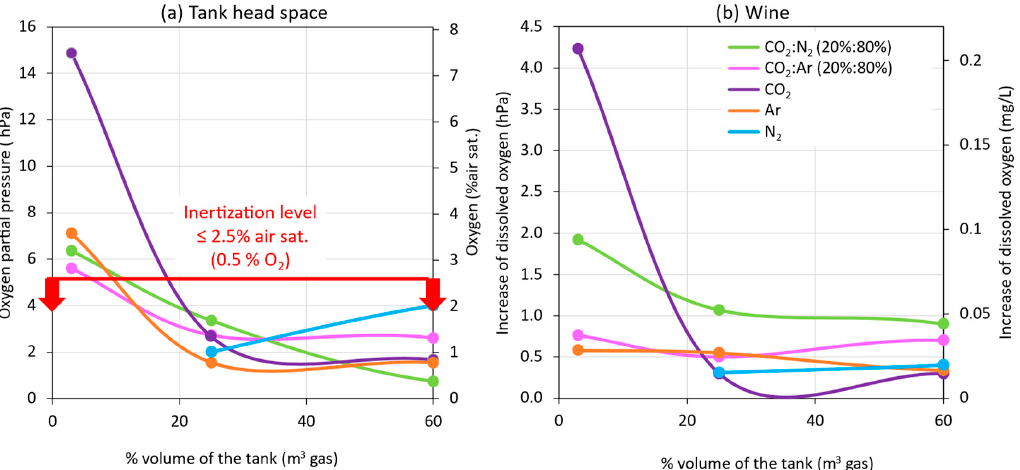
Figure 8. Comparison of the efficiency of inerting (purging or flushing) the destination tank with different gases and intensities during a racking, 0.3 m over wine surface ( a ), and 0.1 m under racked wine surface ( b ).